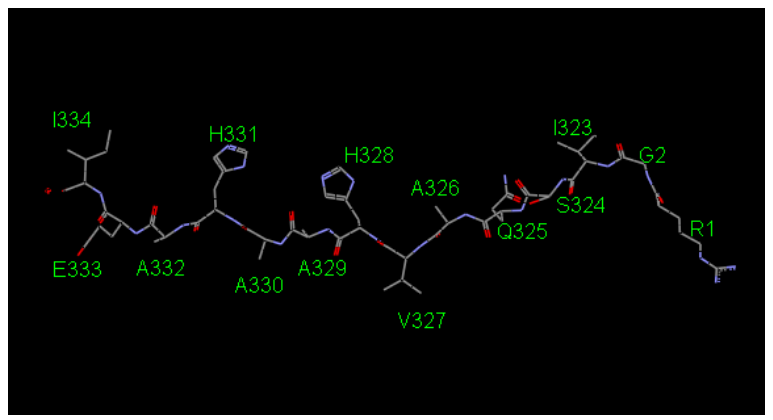
Figure 1. 3D structure of the template OVApeptide excised from the crystal structure (1IAO). Table 1. Result of the first AutoLudi screening. For each amino acid position of the 14-mer peptide, amino acid residues with higher Ludi score than Gly are listed in the descending order of the score along with the original residue. Those residues with Ludi scores higher than the original ones are shown in bold face. The amino acid residues chosen manually for the subsequent second screening are marked with an asterisk (*).